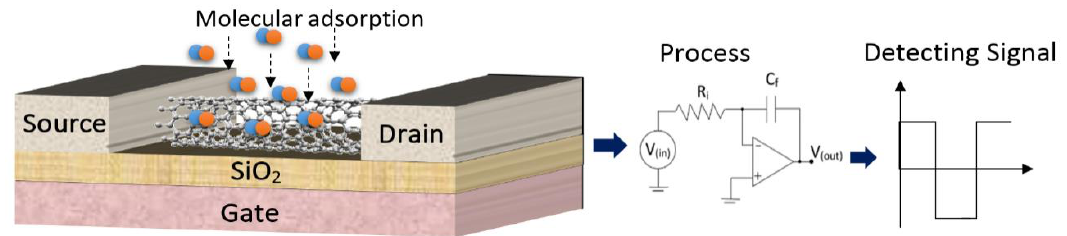
Figure 2. Illustration of a carbon nanotube FET based gas sensor.